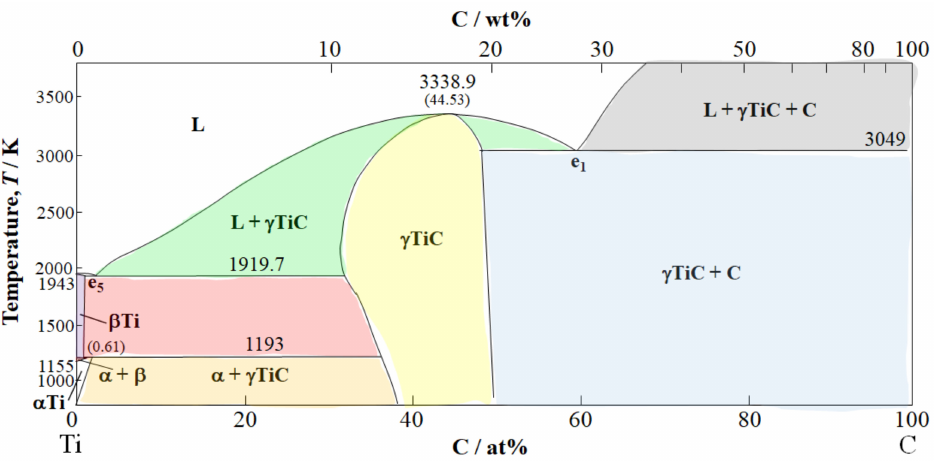
Figure 7. Ti-C phase diagram adapted from Bandyopadhyay, Sharma, and Chakraborti (2000) [72]. The process starts during rapid heating when C contamination up to 1.2 wt.% in the Ti liquid alloy decreases the melting point from 1943 to 1919 K (1670 to 1646 ◦ C) at the eutectic point. In the thin layer around the carbon fibers, higher C contamination from 1.2 to 43 wt.% tremendously enhances the liquidus from 1721 K (1448 ◦ C) to a maximum of 3338.85 K (3065.7 ◦ C) [72]. Hence, Ti solid solutions with possible trace crystalline TiC are formed at the CF–molten Ti interface